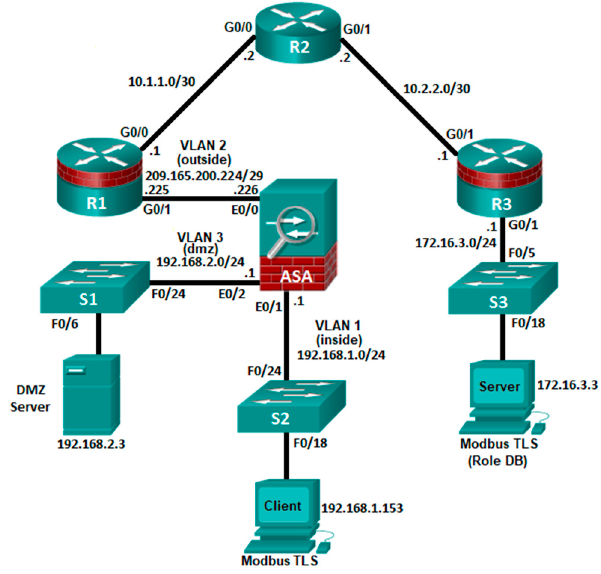
Figure 10. Diagram of the architecture deployed on GNS3.